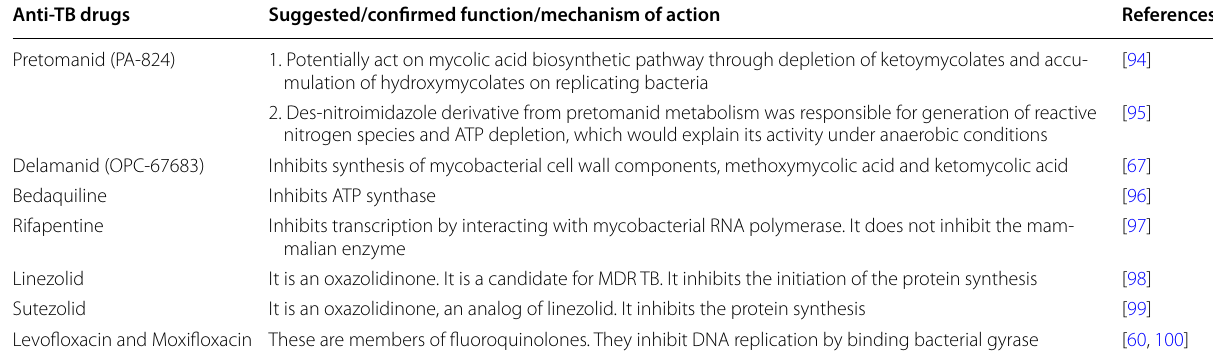
Table 1 Summary of representing some of the new drugs and their functions Anti-TB drugs Suggested/confirmed function/mechanism of